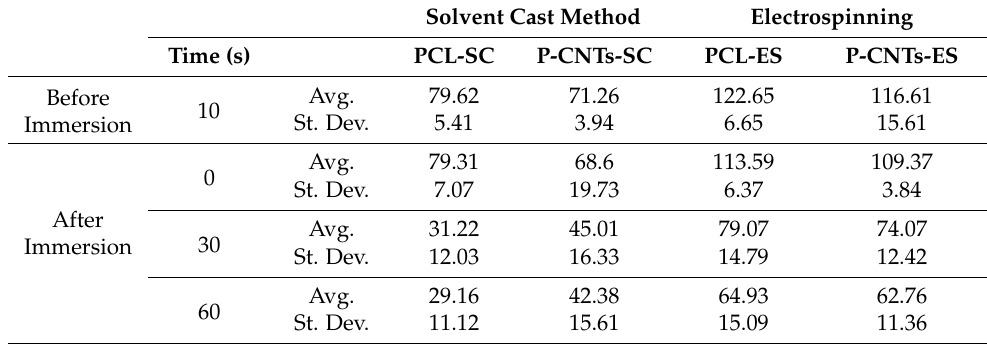
Table 4. Contact angle before and after immersion of the scaffolds in culture medium, for 24 h.